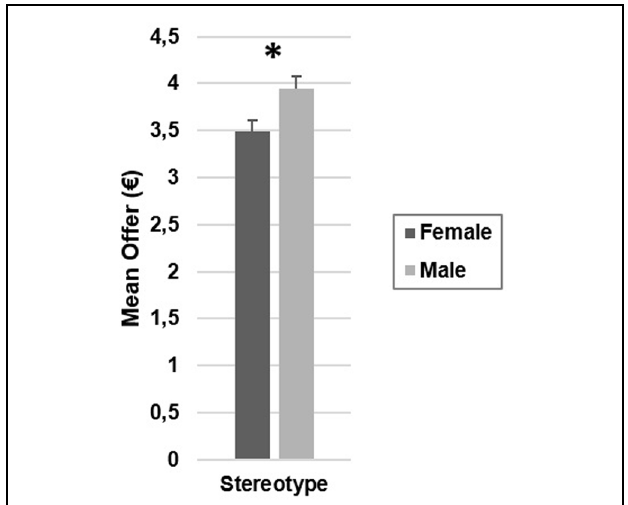
FIGURE 1 | Mean offers as a function of responders’ gender stereotypes. Error bars represent standard errors. ∗ p < 0.001.